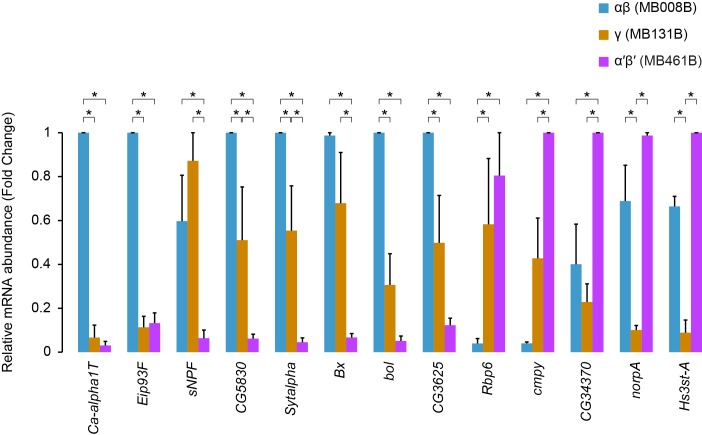
– Confirmation of Kenyon Cell type specific gene expression using qPCR on FAC-sorted cells.Relative difference of expression levels for some of the genes identified in Figure 2F. For each gene, in each replicate, expression values were normalized to the lowest ΔCt across the three lobes. n = 3, * Adjusted p-value<0.05 (Two-way ANOVA with Tukey's multiple comparisons test).